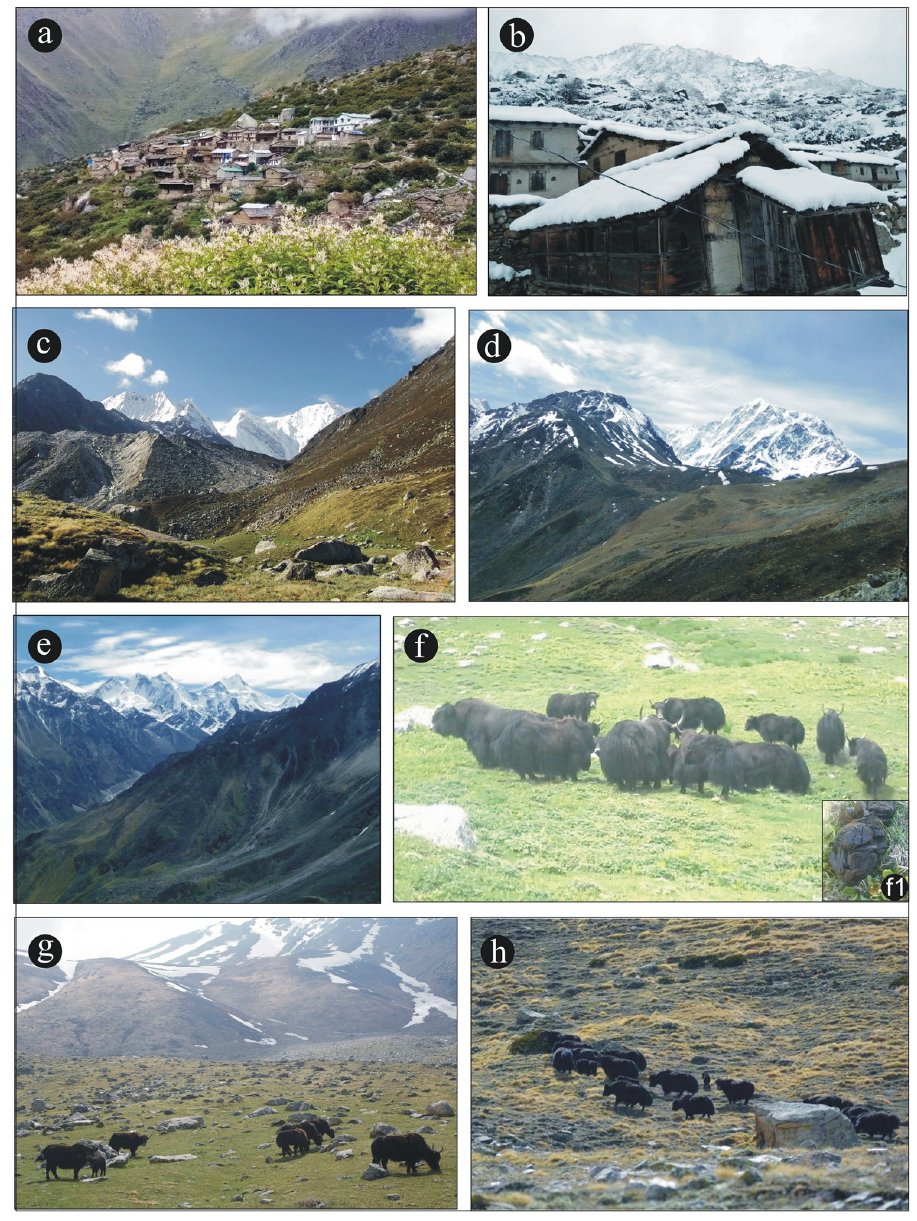
Fig 1. Field photographs. a. Dronagiri village inhabited by Bhotiyas near Indo-Tibet border, b. A view during winter snow fall, c. A view of Alpine meadow vegetation, d, & e. A view of Alpine steppe vegetation, f. A group of wild Yak during resting time in Alpine meadow vegetation, f1. Close up of Yak dung, g. A group of yak during grazing in Alpine steppe vegetation surrounding glacier point, h. Yak migration toward higher altitude during summer.